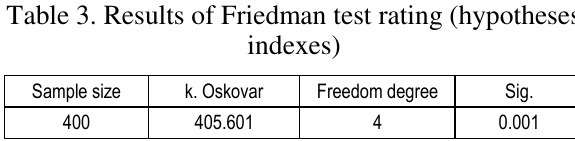
Table 3. Results of Friedman test rating (hypotheses